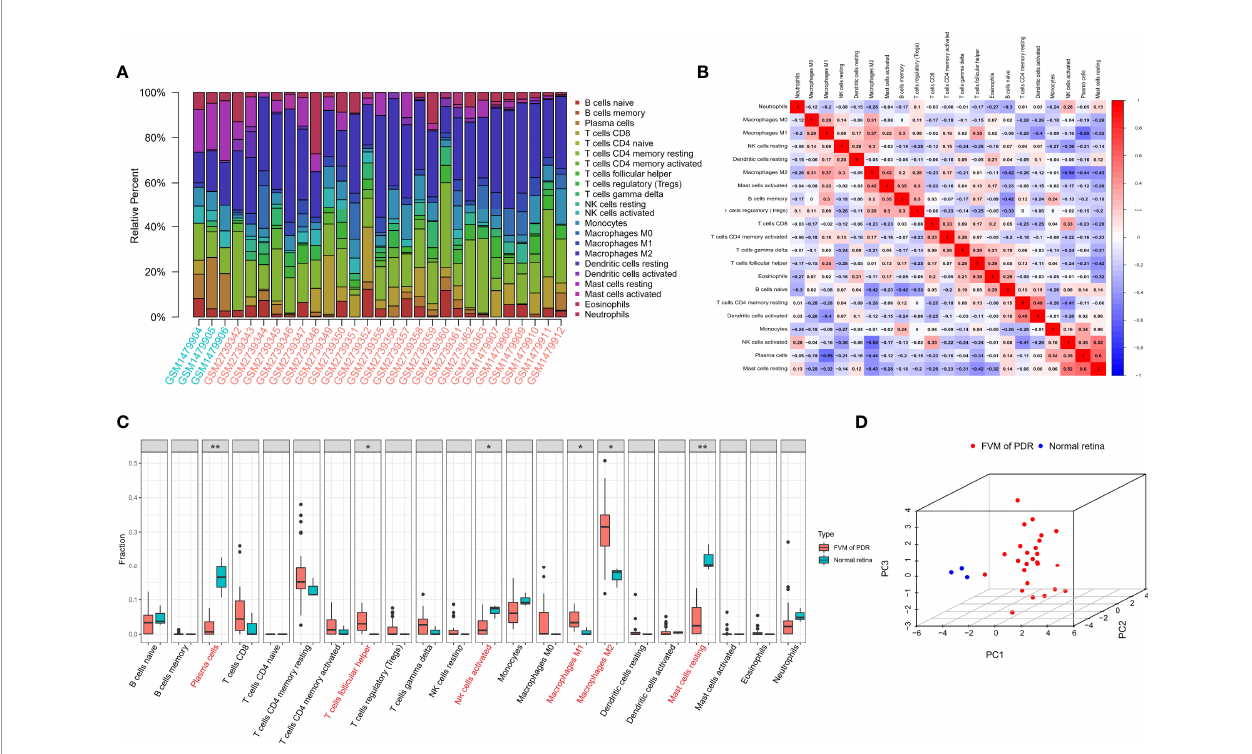
FIGURE 3 | Immune in fi ltration landscape in FVM and normal retinal tissue. (A) Bar charts of 22 immune cell types in all eligible samples. (B) Correlations between in fi ltrating immune cells. Red and blue colors indicate positive and negative correlations, color intensity represents the degree of correlation. (C) Box plot of the difference in immune cell content between the FVM group and control group (*p < 0.05; **p < 0.01). (D) 3D scatter plot of PCA